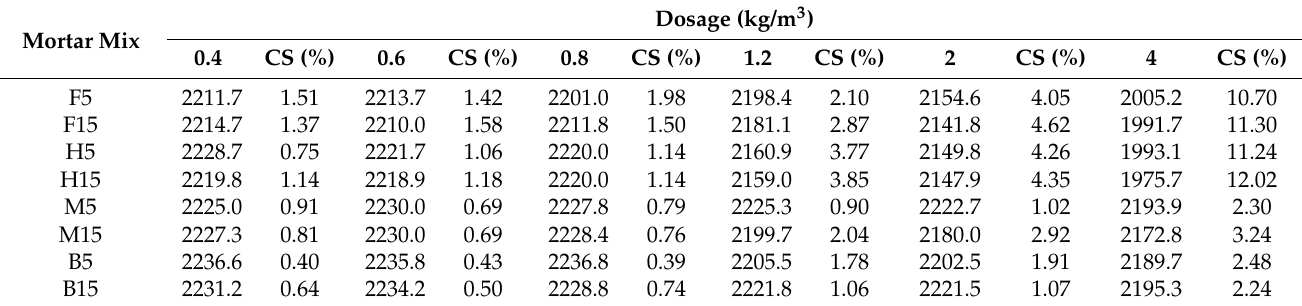
Table 7. Density (kg/m 3 ) mean value measured on three specimens for each mortar mix. CS: Control